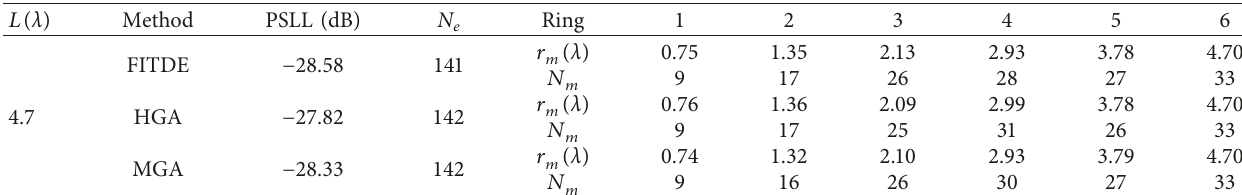
Figure 9: Result of Example 3. (a) PSLL of 50 independent runs in Example 3. The best PSLL is − 28.58dB, the average PSLL is − 28.17dB, and the variance is 0.084. (b) is the best radiation pattern of all planes, characteristic of excellent symmetry. (c) is the sectional pattern of one single plane. (d) is the optimal distribution of elements. Table 7: Results of Example 3.